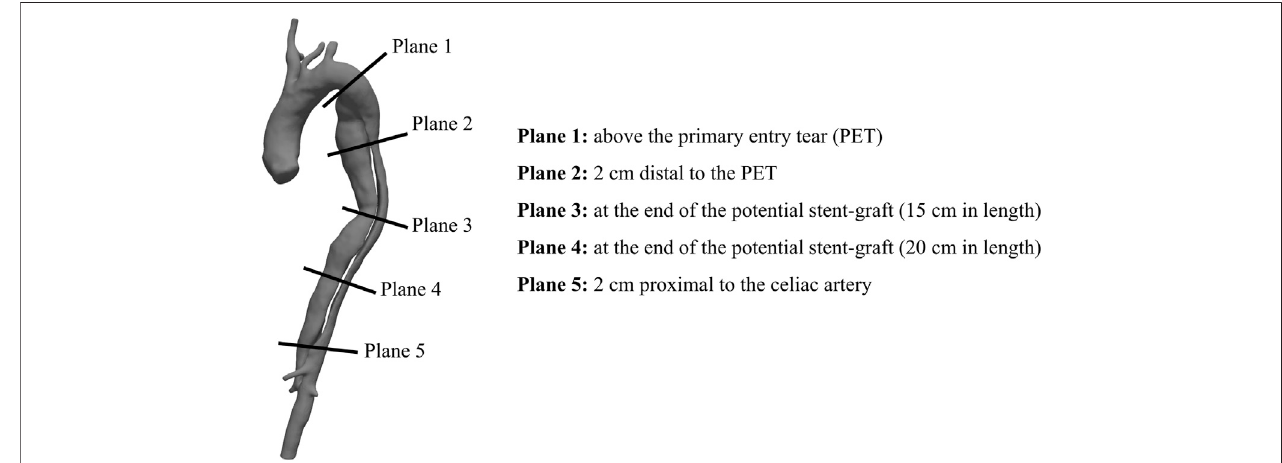
FIGURE 2 | Cross-sections exempli fi cation for post-processing (Right) Exempli fi cation of the fi ve cross-sectional planes selected along the aorta for 4D fl ow MRI analysis (Left) Volumetric reconstruction of a post-TEVAR aortic geometry (Patient 1) with stent-graft end pointed in